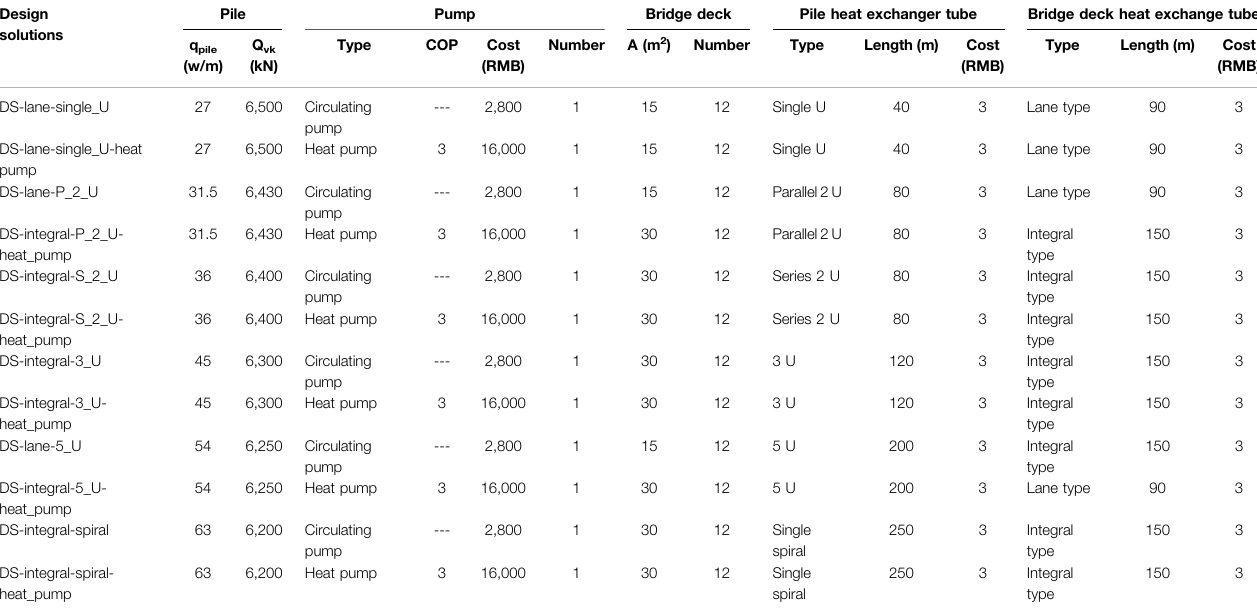
TABLE 2 | The detail of the design solution.